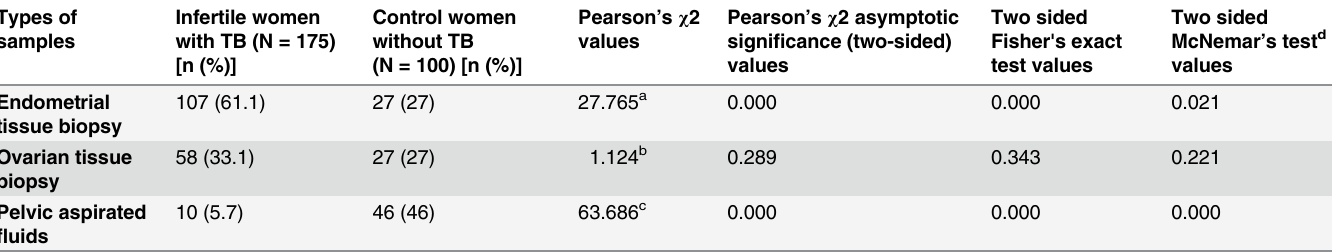
Table 3. Statistical association of different tissue biopsies (site specific pathology) among case-control groups. Types of